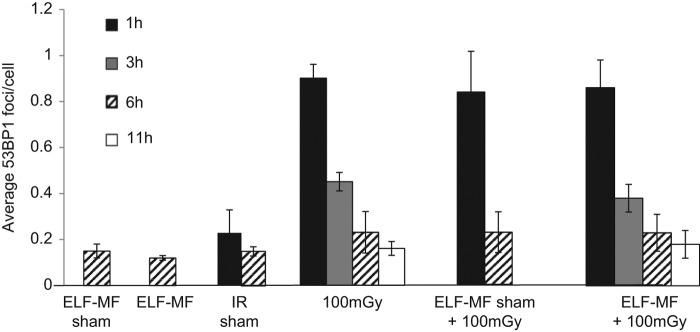
Analysis of 53BP1 foci formation and disappearance after in utero exposure of embryos to ELF-MF at 300 μT, 100 mGy IR, or combined exposures. 53BP1 foci were quantified at 1, 3, 6, or 11 h post IR in the VZ/SVZ following sham exposure, exposure to 50 Hz ELF-MF at 300 μT, 100 mGy IR or both. Embryos (E13.5) were exposed in utero. Results represent the mean of 2 sections from 3 embryos from each of 4 mothers (i.e., a sample size of 24). Only two mothers were examined for IR sham (i.e., a sample size of 12). Error bars are standard deviation of repeat measurements (at least 2 animals per group).